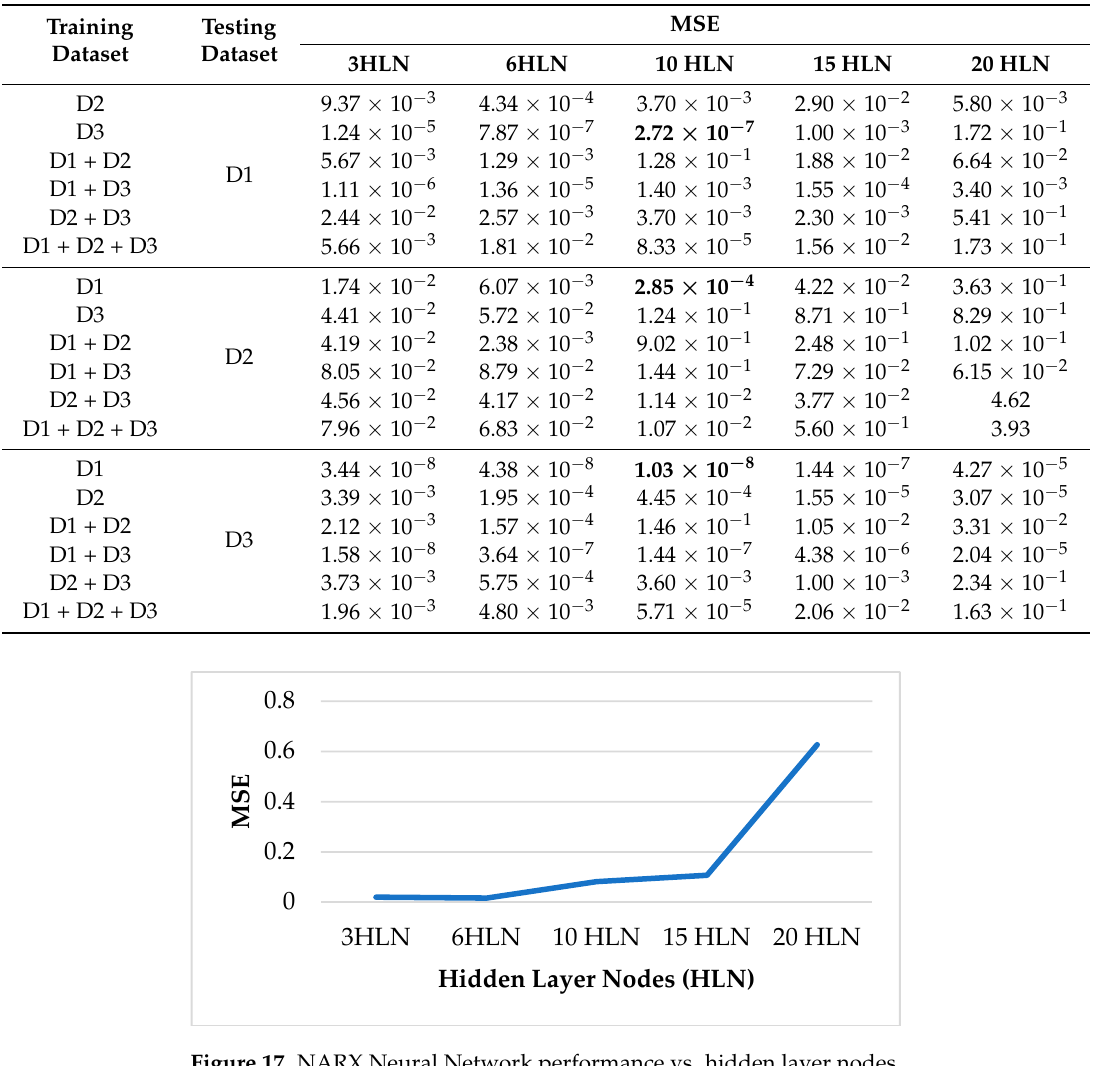
Table 2. Nonlinear autoregressive models with exogenous inputs (NARX) Network results. Training Dataset